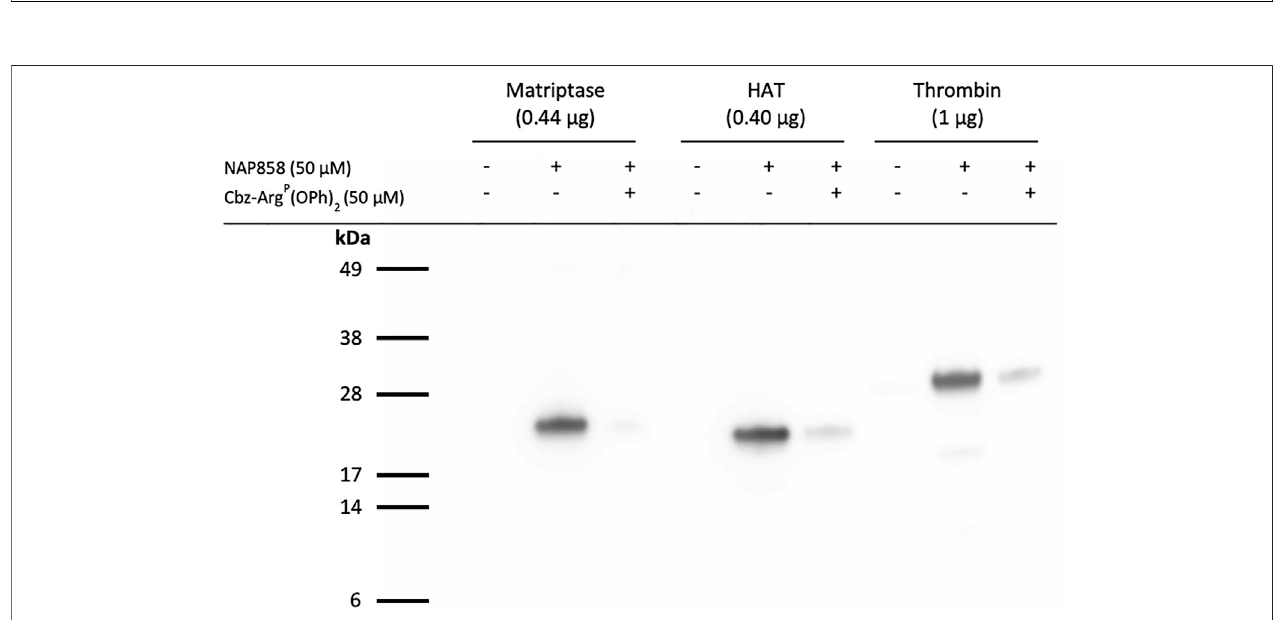
FIGURE 11 | NAP858 functions as an activity probe (AP) for TLPs. Proteases, matriptase, HAT and thrombin, were treated (±) NAP858 (±Cbz-Arg P (OPh) 2 ), for 30 min at 37 ° C. Samples were resolved by SDS-PAGE under reducing conditions with streptavidin-HRP used to visualise the inhibitor-protease complex.